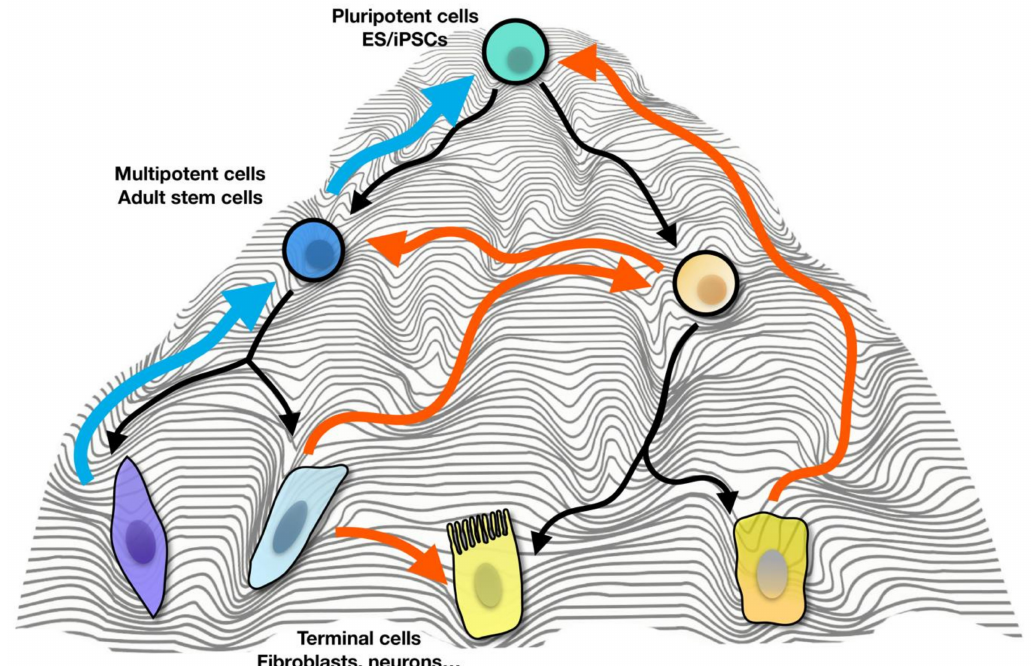
Figure1. Cellfateplasticityandtheepigeneticlandscapecurrentlyappliedfordirectcellreprogramming. Pluripotent cells, including embryonic stem cells (ES) and induced pluripotent stem cells (iPSCs) can di ff erentiate into any type of multipotent or adult cells (black arrows) which in turn can di ff erentiate into terminal cells (e.g., fibroblasts, neurons, and astrocytes). This can happen naturally during their development or in response to external factors if done in vitro. The paths which takes either a di ff erentiated cell or a multipotent cell back to the pluripotent / stem cell state is shown here in blue arrows. Transdi ff erentiation (orange arrows) is the process by which the terminally di ff erentiated cell or adult cell can be converted into any other terminally di ff erentiated cell or adult cell without passing by a pluripotency state. Di ff erentiated cells can also be directly converted into the pluripotency state via the process of transdi ff